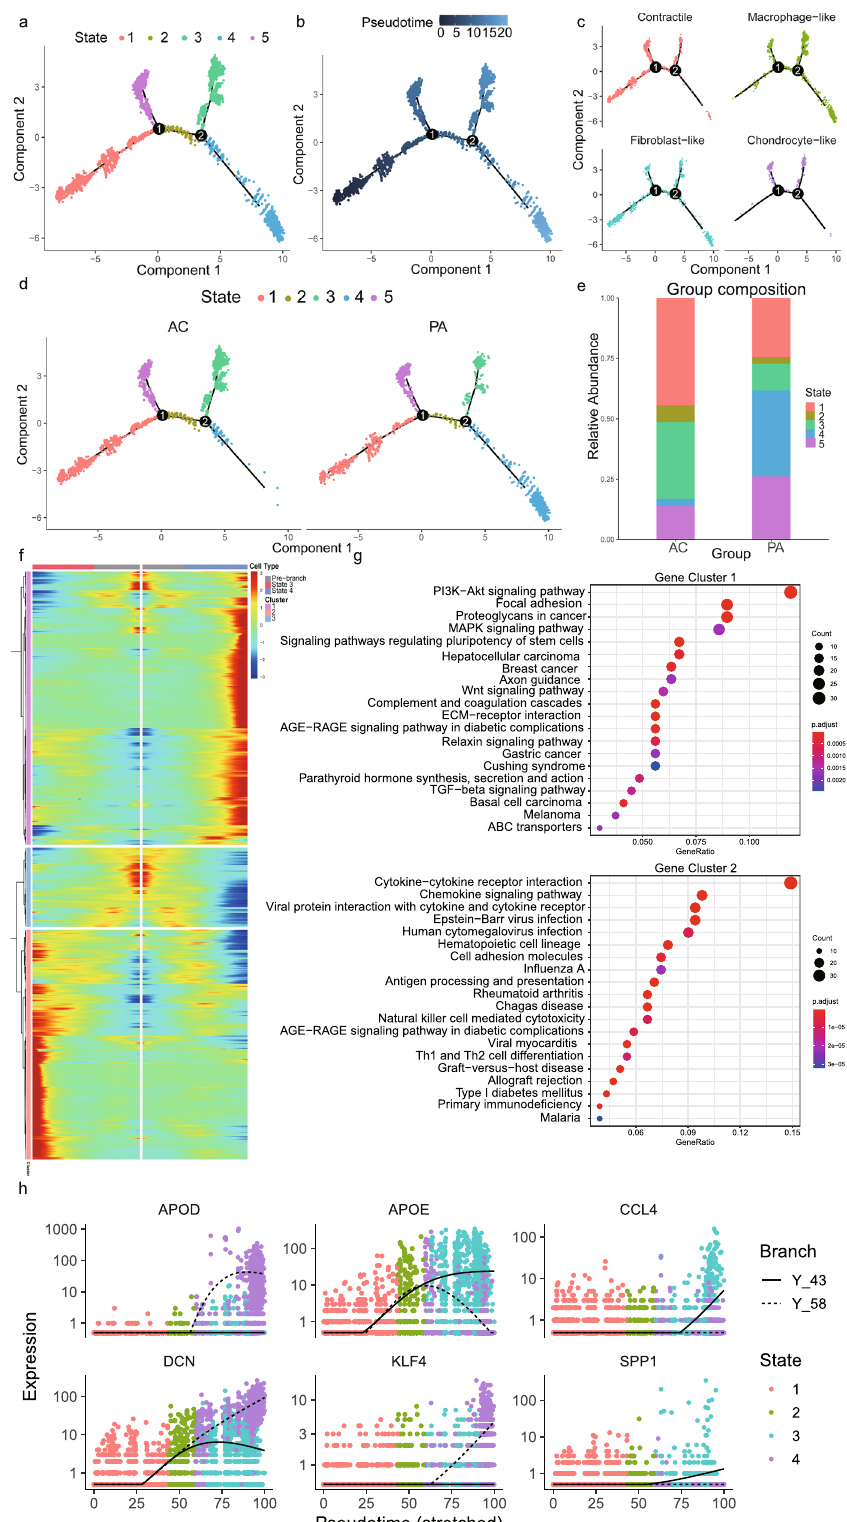
Alterations in macrophage-like VSMC cellular interactions . To further understand the contribution of cellular crosstalk to macrophage-like VSMC functional alteration, we employed NicheNet. In the PA group, the cell-to-VSMC interactions were dominated by NK, myeloid, and T signals (Fig. 5a). With disease progression, we observed an increase in endothelial, myeloid